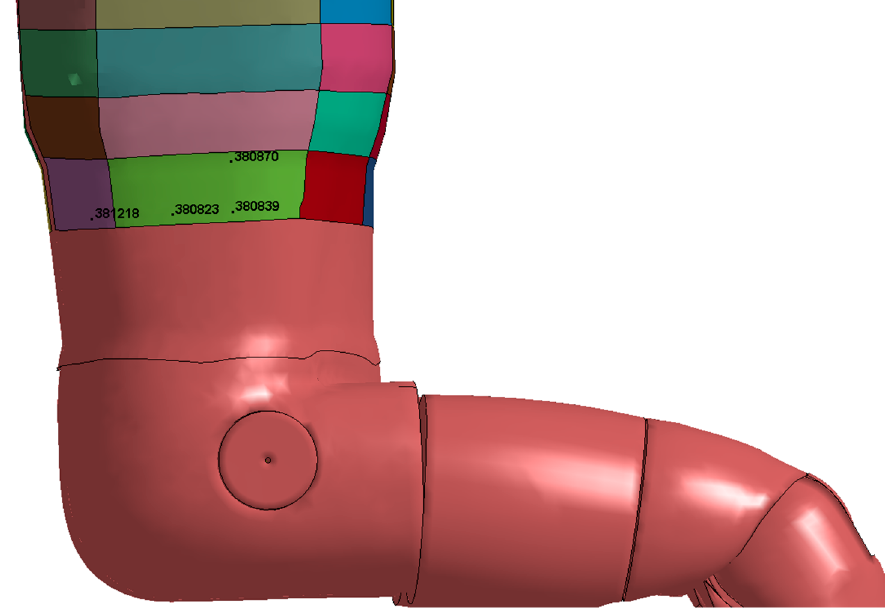
Figure 7. Location of node IDs referenced in Table 10.